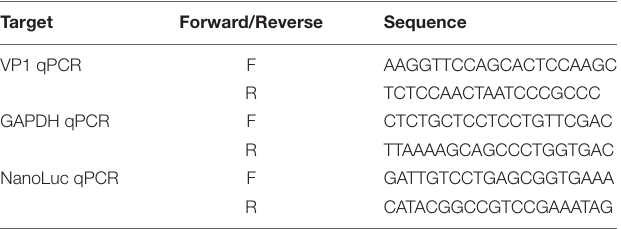
TABLE 2 | Primers used for qPCR.